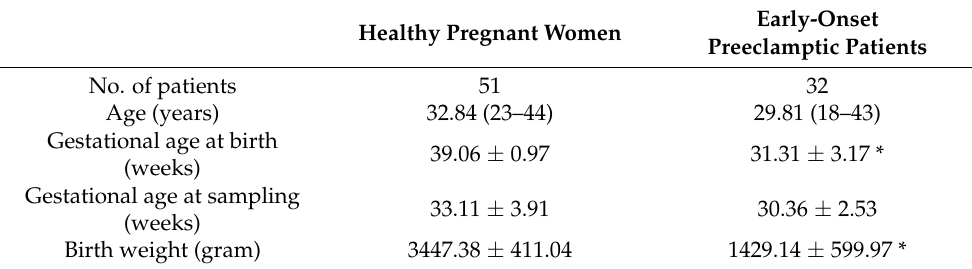
Table 1. Patients’ demographic and gynecological